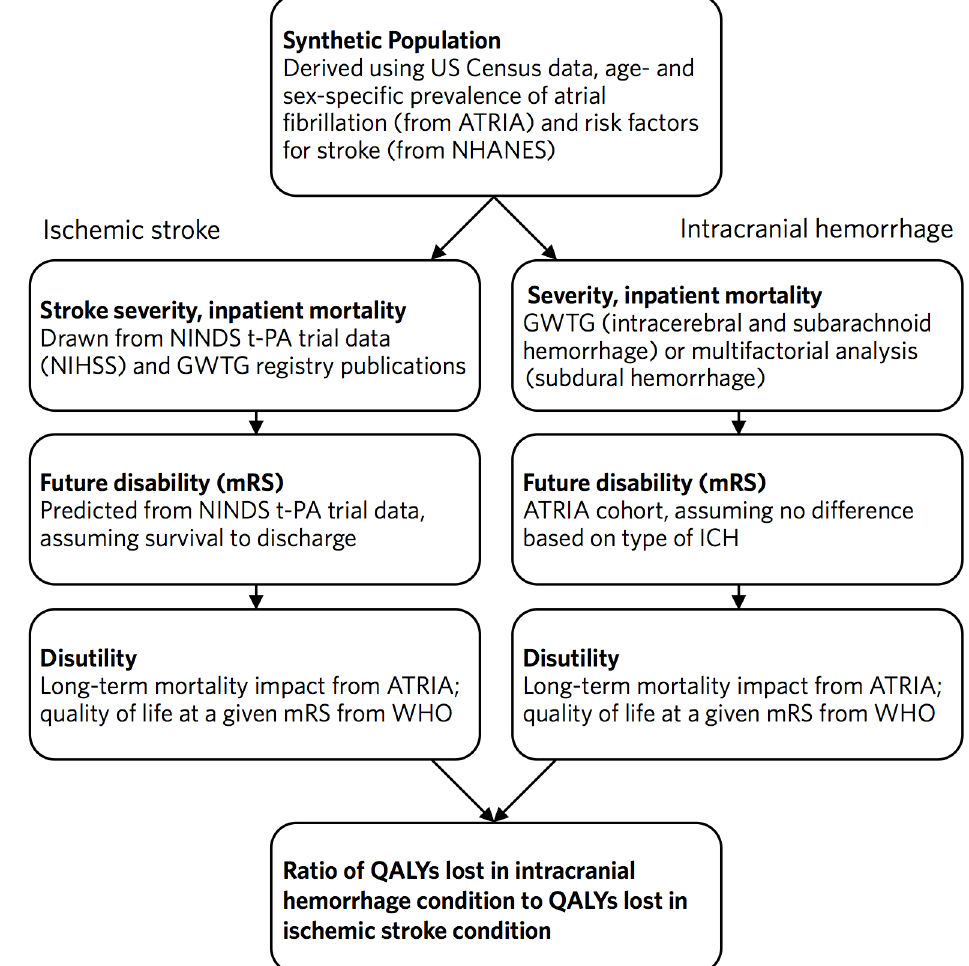
Fig 1. Schematic diagram of microsimulation